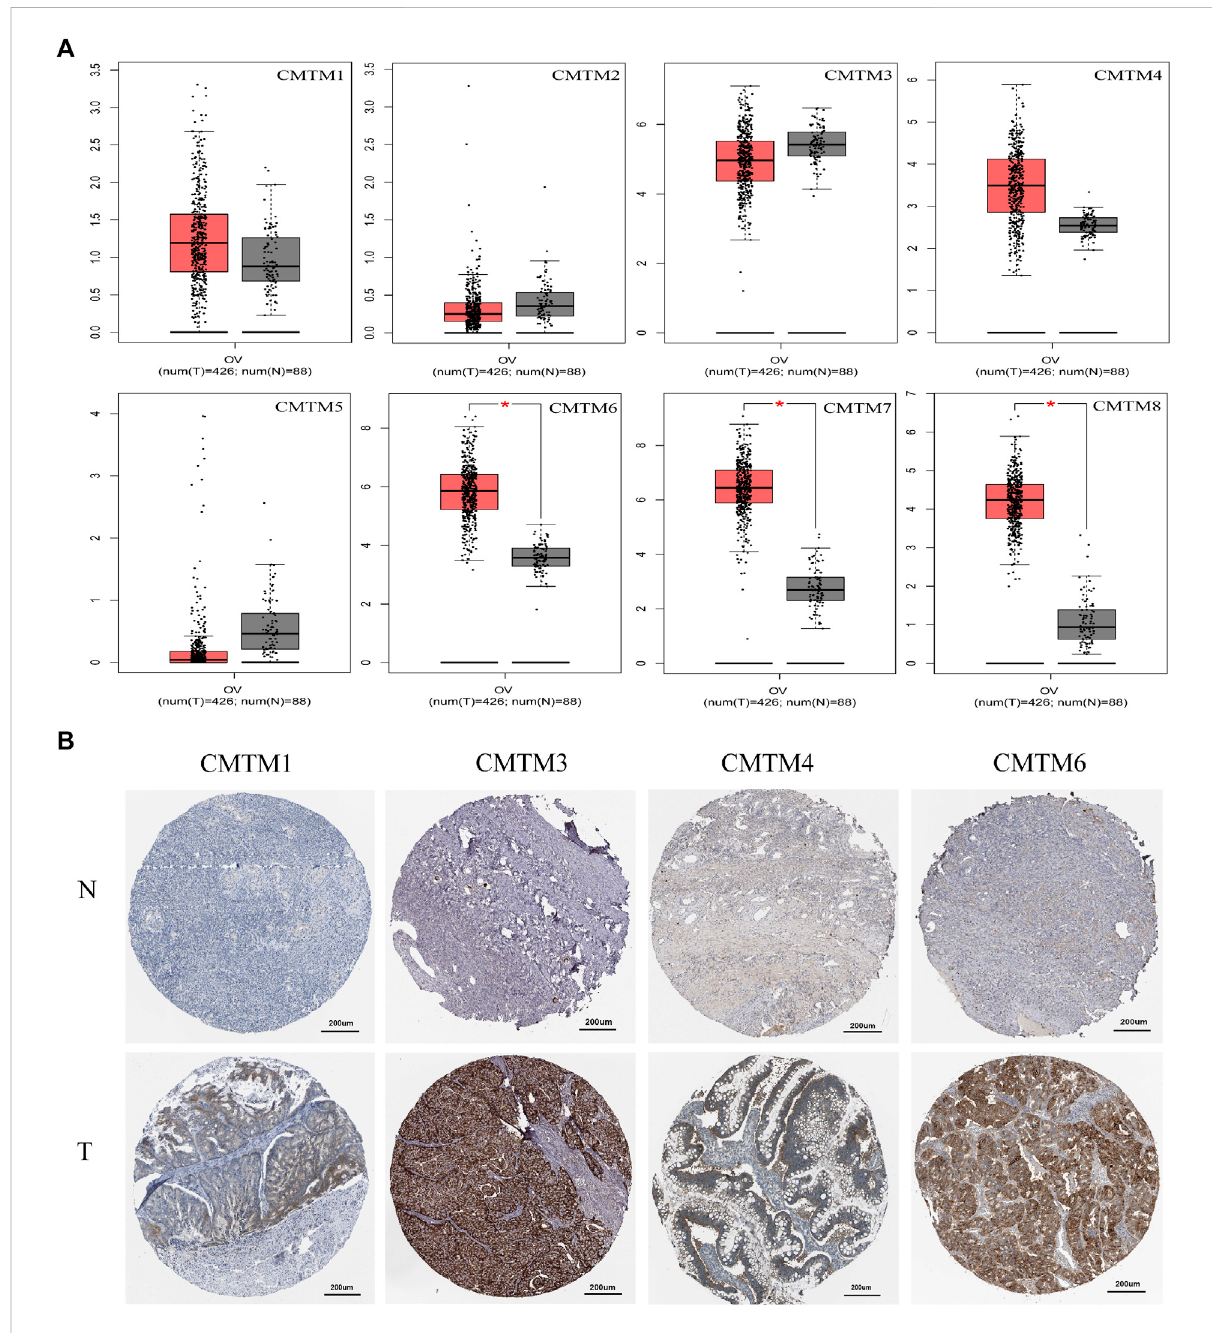
FIGURE 2 TheexpressionlevelsofeachmemberoftheCMTMfamilyatthemRNAandproteinlevelsinovariancancertissueandnormalovariantissue. (A) Box plot of mRNA expression of different CMTM family members in OV tissue ( n = 426) and normal ovarian tissue ( n = 88) based on the GEPIA database. Compared with normal samples, the mRNA expression of CMTM6/7/8 was found to be relatively high in OV tissue at the mRNA level (* p < 0.05). (B) ImmunohistochemicalstainedsectionsofCMTM1/3/4/6inOVtissueandnormalovariantissuebasedonHPAdatabase.Itcanbeseen thatthehigherstainingintensityinOVtissuemeansthatCMTM1/3/4/6wasrelativelyhighlyexpressedattheproteinlevelinovariancancer.TheIDof the sample and the antibody used were recorded. CMTM1 (ID: 2713; ID: 1310; Antibody: HPA13801), CMTM3 (ID: 2004; ID: 3116; Antibody: HPA072695), CMTM4 (ID: 2159; ID: 1844; Antibody: HPA023890, HPA014704), CMTM6 (ID: 2713; ID: 2347; Antibody: